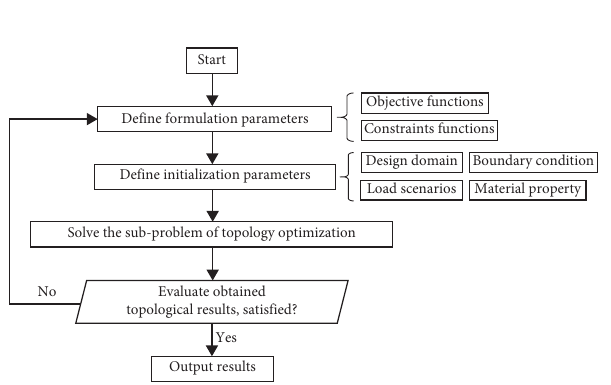
Figure 1: Morphology generation